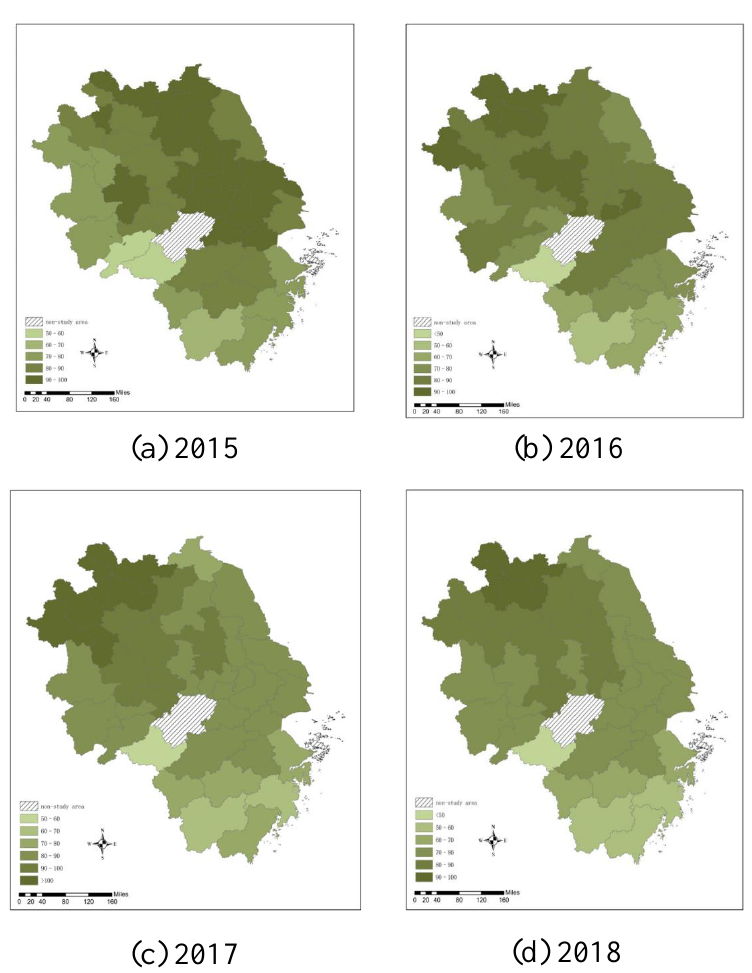
Figure 2. Spatial distribution of the AQI level in the YRD from 2015 to 2018 .